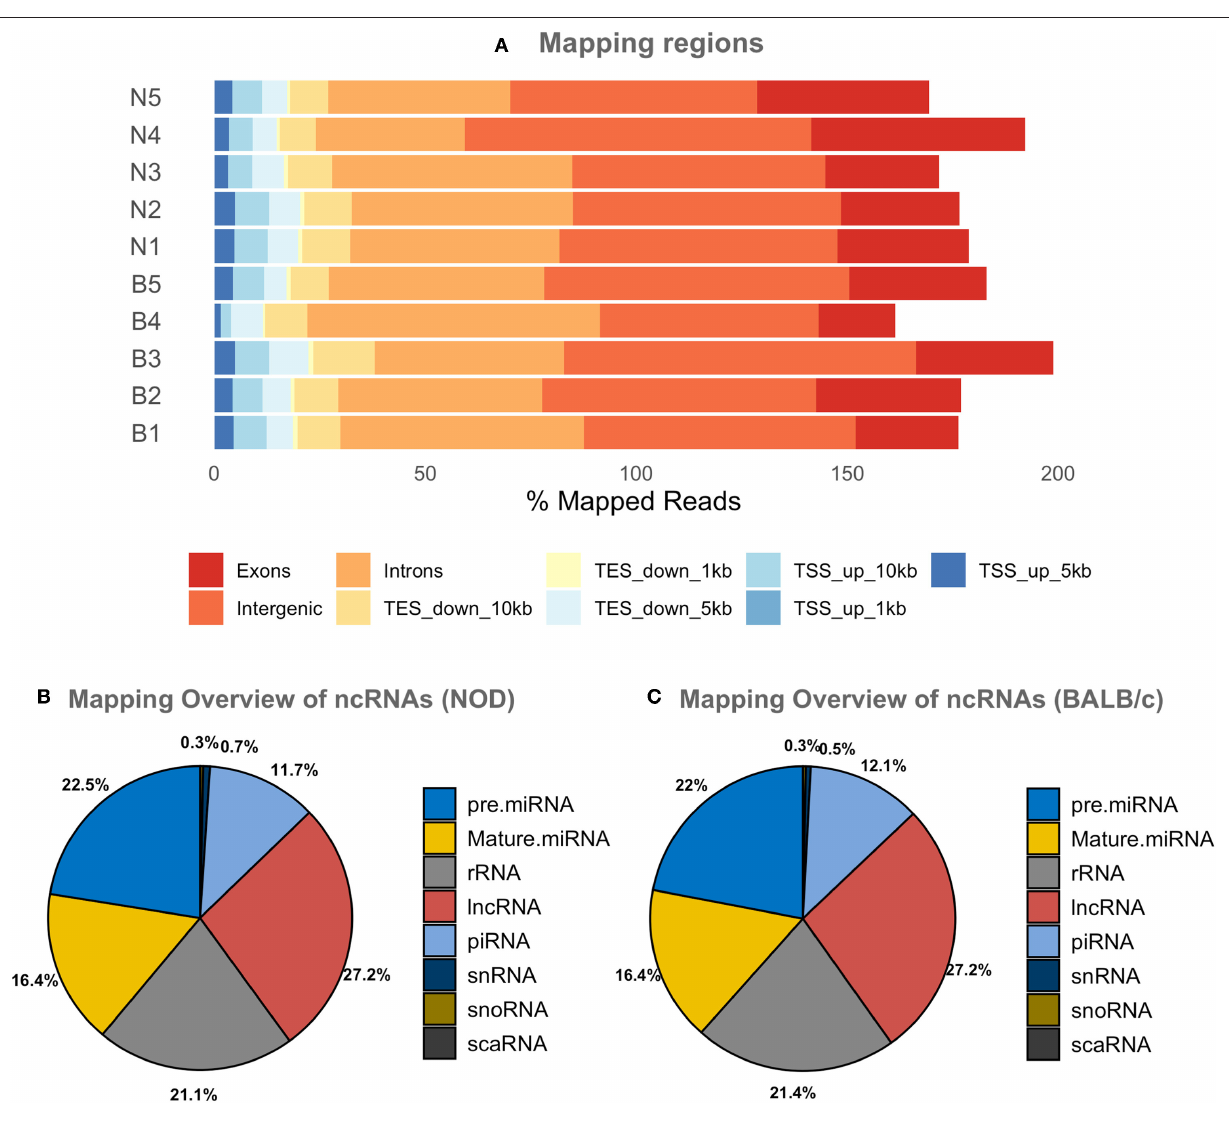
FIGURE 2 | Graphical presentations of the distribution of reads from NGS sequencing of RNAs. (A) Shows the regions of the mouse genome that reads of all samples were aligned to. The mapping percentage is > 100 as multi-mapping reads were also counted. No significant sample to sample variation was observed. (B,C) Show the distribution of reads aligning to various ncRNAs in NOD & BALB/c serum UC exosomes. Results were obtained from n = 5 UC serum exosome samples per mouse strain, with each sample comprising pooled serum exosomes from five mice. TSS, Transcription Start Site; TES, Transcription End Site; kb, kilobases; pre miRNA, precursor microRNA; rRNA, ribosomal RNA; lnc RNA, long non-coding RNA; snRNA, small nuclear RNA; snoRNA, small nucleolar RNA; scaRNA, small cajal body specific RNA; mature miRNA, mature microRNA; piRNA, piwi interacting